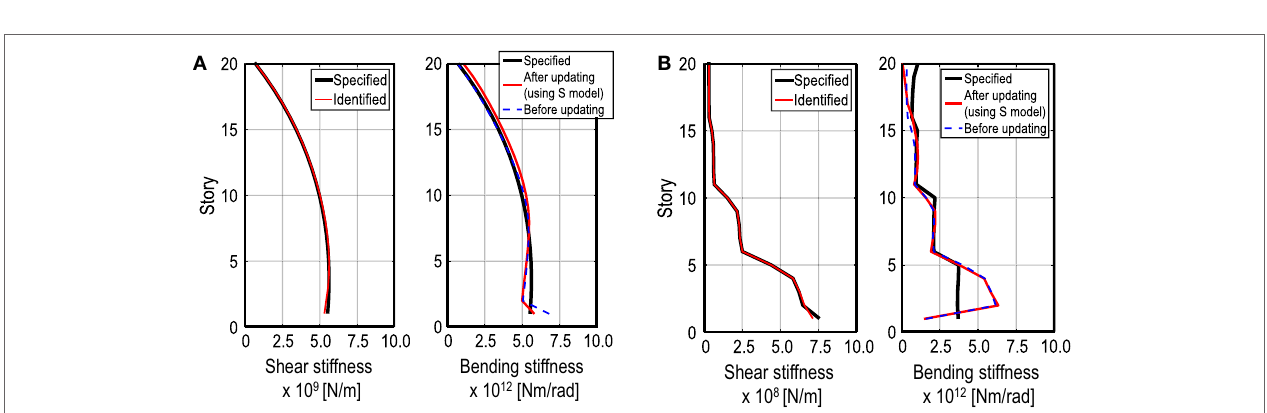
FIGURE 12 | Stiffness identification using theoretical identification function of SB model: (A) Model A and (B) Model B .